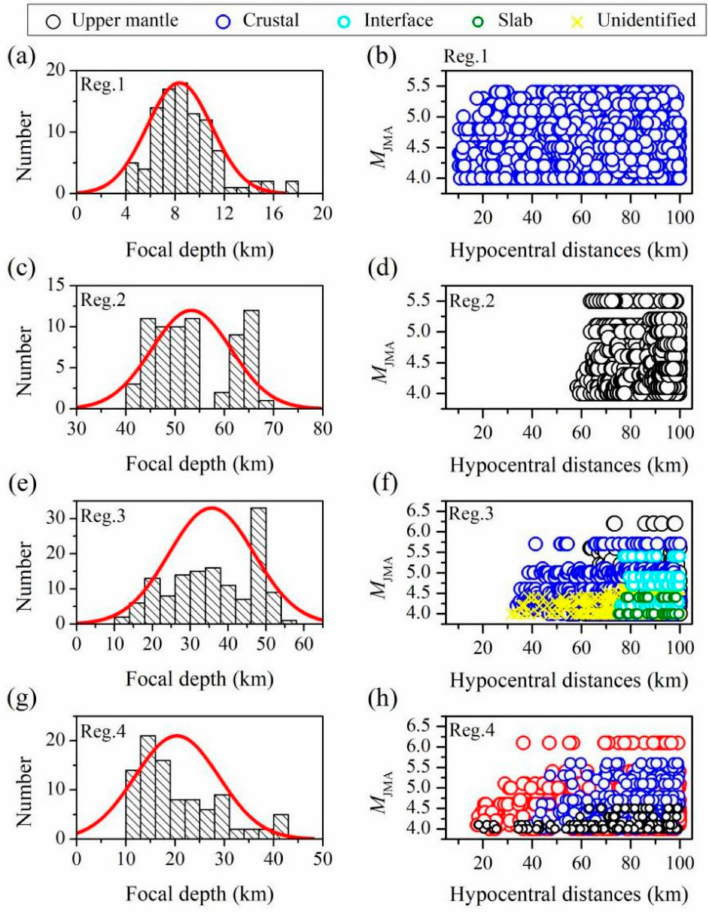
Figure 6. Histogram of the focal depth for ( a ) Reg.1, ( c ) Reg.2, ( e ) Reg.3, and ( g ) Reg.4. Distribution of hypocentral distance vs. magnitude of the records used for ( b ) Reg.1, ( d ) Reg.2, ( f ) Reg.3, and ( h )